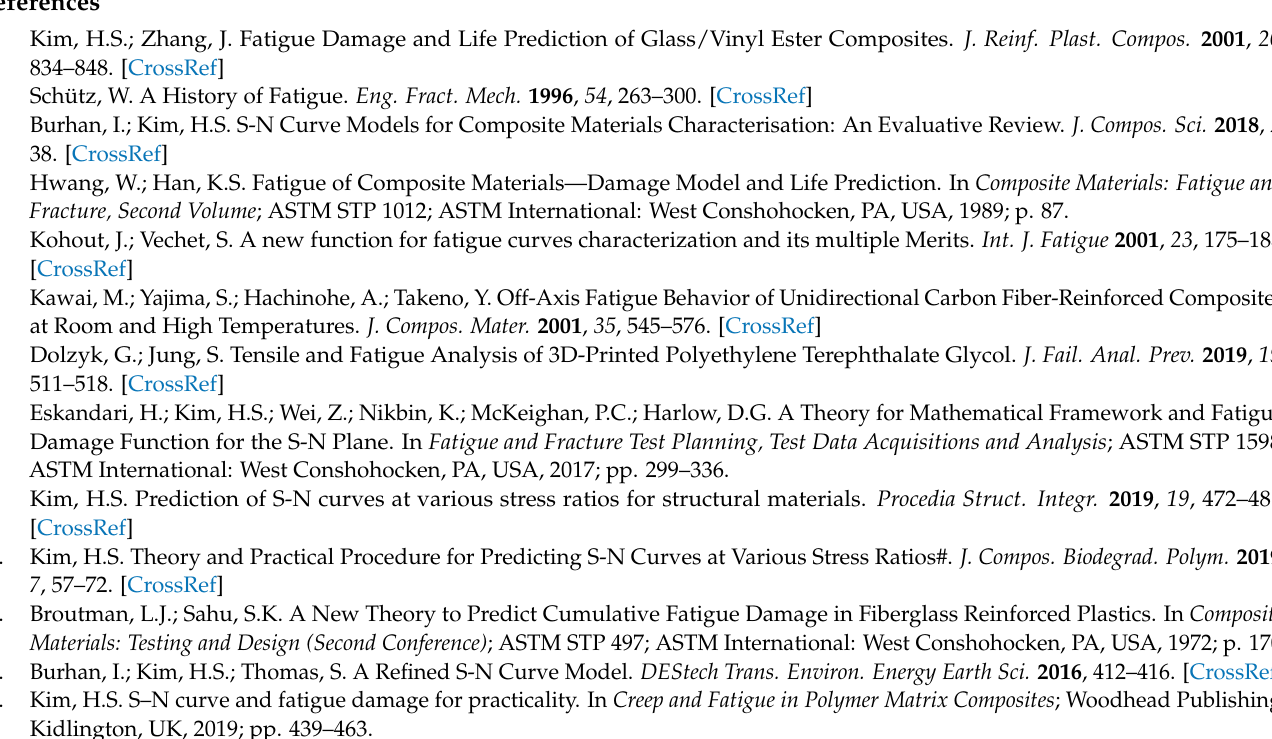
figure, plot(logNf, Smax, ‘o’,‘MarkerSize’, 8,‘MarkerEdgeColor’, ‘k’, ‘MarkerFace- Color’, [1 0